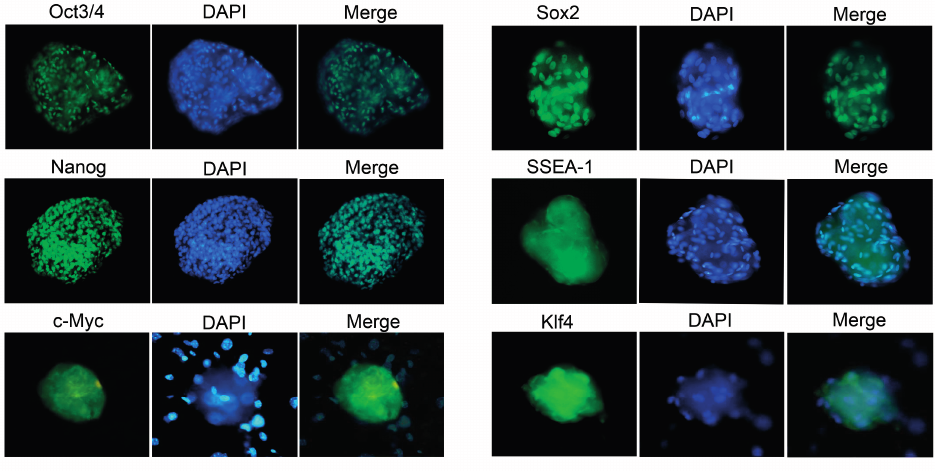
Figure 8. Immunofluorescence identification of the generated iPS. The newly derived mRNA iPS colonies were stained for the specialized markers of pluripotency: Oct4, Sox2, Nanog, SSEA-1, Klf4 and c-Myc. Nuclei were counter-stained with DAPI; (magnification 200×).